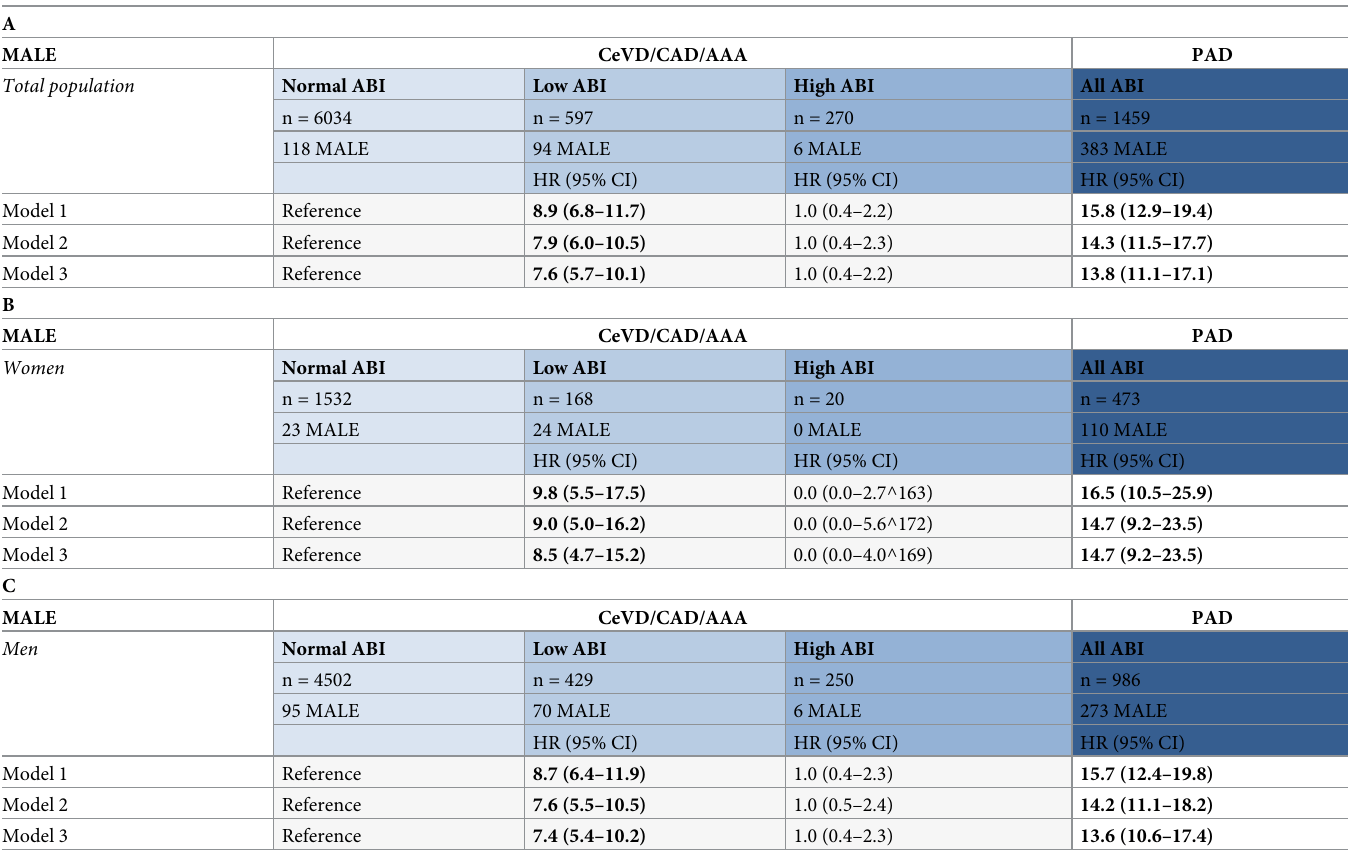
Table 4. The association between screen-detected abnormal ABI scores & manifest PAD and future MALE.